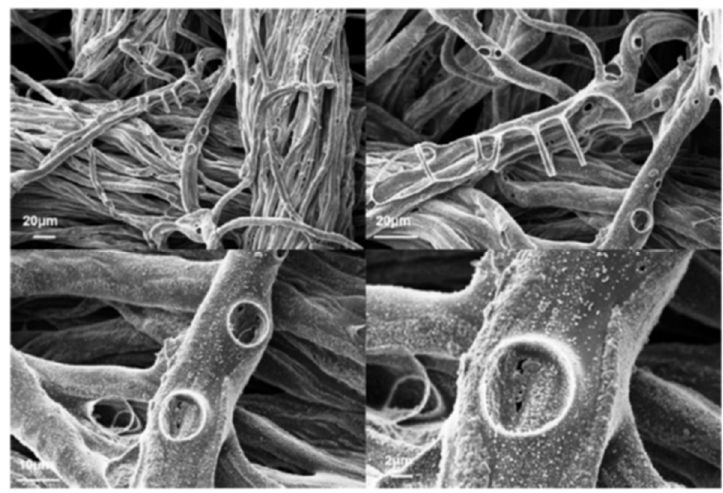
Figure 7. CC HRR curves for cotton, casein, and hydrophobin-treated cotton [36].